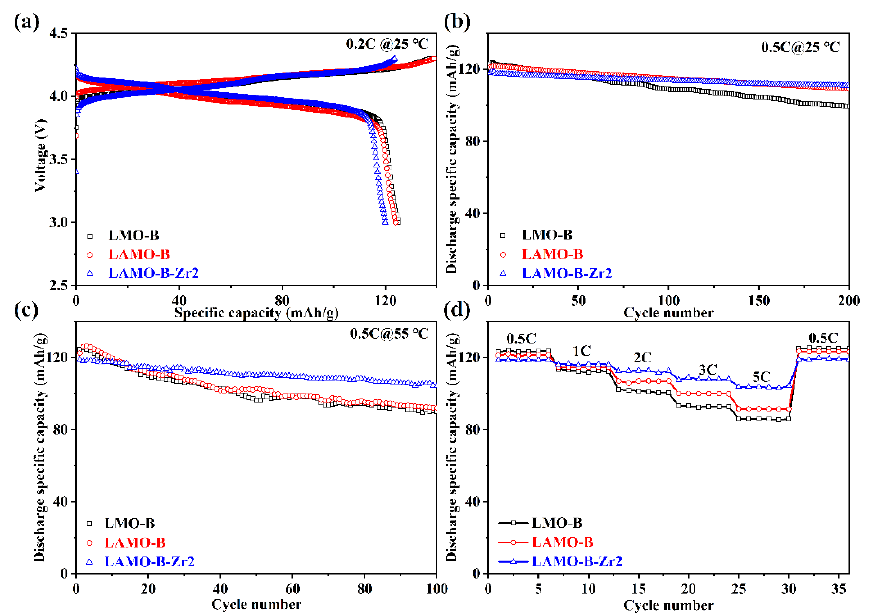
Table 2. The capacity retention ratios of LMO-B, LAMO-B, and LAMO-B-Zr2. Figure 7. The electrochemical performance of the LMO-B, LAMO-B, and LAMO-B-Zr2 cells. ( a ) The Samples initial charge-discharge profiles at 0.2° C and 25 °C. The cycling stability with 0.5C rate at ( b ) 25 °C ( a ) The initial charge-discharge profiles at 0.2 ◦ C and 25 ◦ C. The cycling stability with 0.5C rate and ( c ) 55 °C. ( d ) The rate performance at 0.5C, 1C, 2C, 3C, and 5C, respectively. at ( b ) 25 ◦ C and ( c ) 55 ◦ C. ( d ) The rate performance at 0.5C, 1C, 2C, 3C, and 5C,